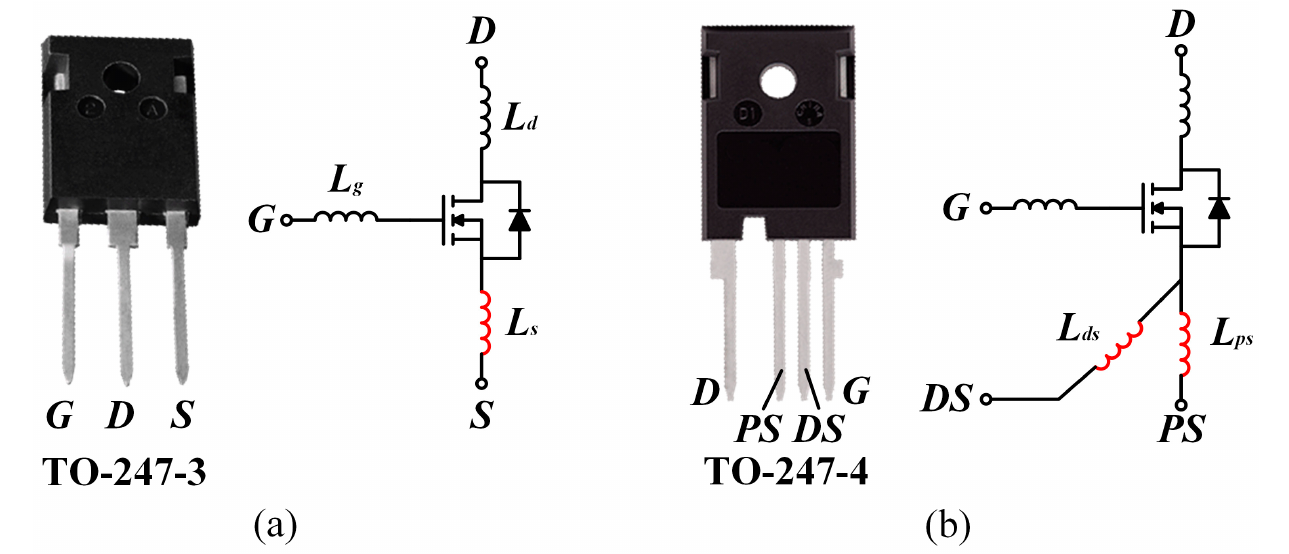
Figure 2. Structures of discrete SiC MOSFET with non-Kelvin package and Kelvin package. ( a ) non-Kelvin package (TO-247-3). ( b ) Kelvin package (TO-247-4).